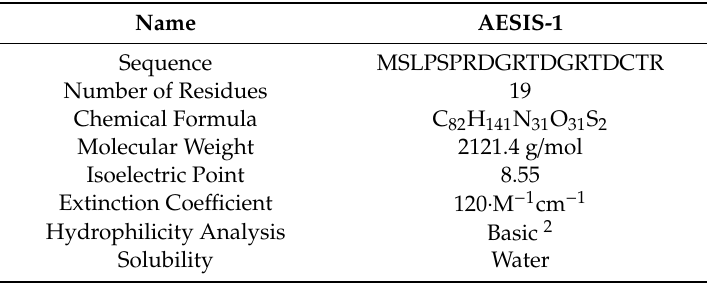
Table 2. The properties of the AESIS-1 peptide 1